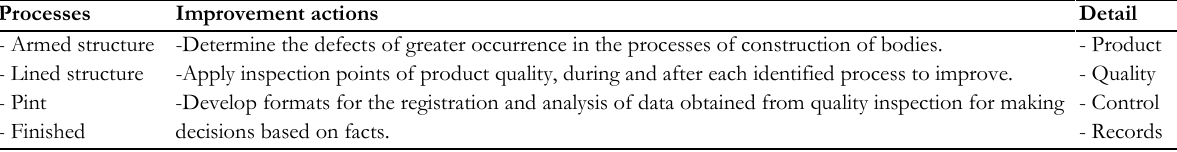
Figure 2. Ishikawa’s Diagram – Paint Process Table 2. Defects of the Structure Assembly Process